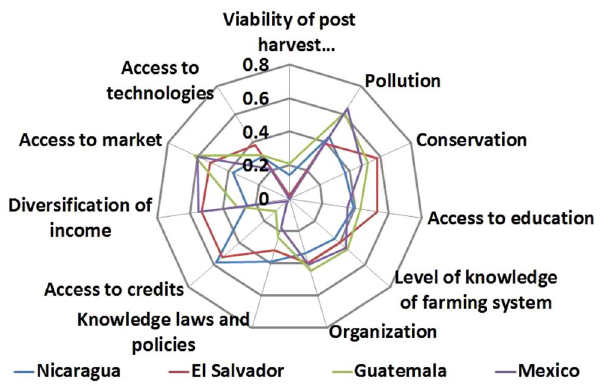
Figure 5. Adaptive capacity indicators in the livelihoods of small coffee producers to climate change in four countries of